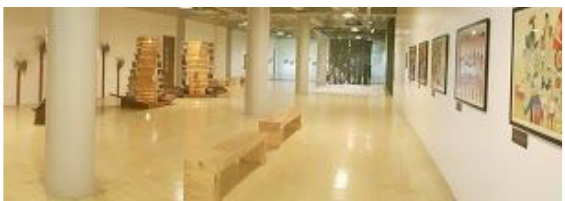
Figure 3. A photograph in a similar view for comparison